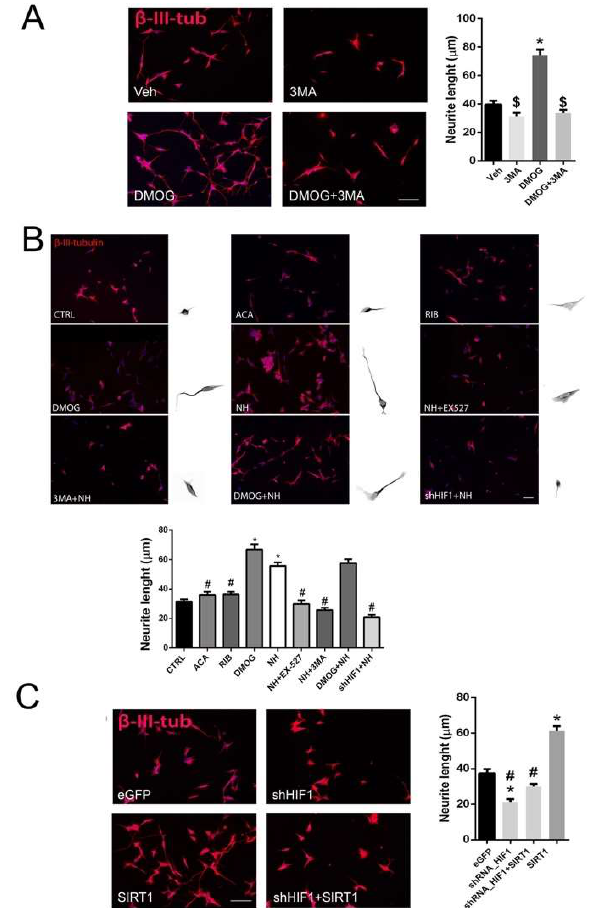
Figure 6. SIRT/HIF1α-autophagy axis activation enhances neurite outgrowth. ( A ) Representative microphotographs and bar graphs showing the mean (±SEM) values of neurite length from SH-SY5Y cells after 24 h of treatment with Vehicle, DMOG, 3-MA, or DMOG+3-MA on transfected cells. (n = 3–4, ANOVA, post hoc Bonferroni * p < 0.05 vs. Veh, $ p < 0.05 vs. DMOG). Scale bar = 100 μm. ( B ) Top , Microphotographs and representative neurons outset 300X magnification. Bottom , bar graphs showing the mean (±SEM) values of neurite length from SH-SY5Y in different experimental groups. (n = 3–4, ANOVA, post hoc Bonferroni * p < 0.05 vs. Veh, # p < 0.05 vs. NH). Scale bar = 100 μm. ( C ) Representative microphotographs and bar graphs showing the mean (±SEM) values of neurite length from SH-SY5Y cells in transfected cells with eGFP, shRNA/HIF1, SIRT-1 or the combination of shRNA/HIF+ SIRT-1. (n = 3–4, ANOVA, post hoc Bonferroni * p < 0.05 vs. eGFP, # p < 0.05 vs. SIRT1). Scale bar = 100 μm.